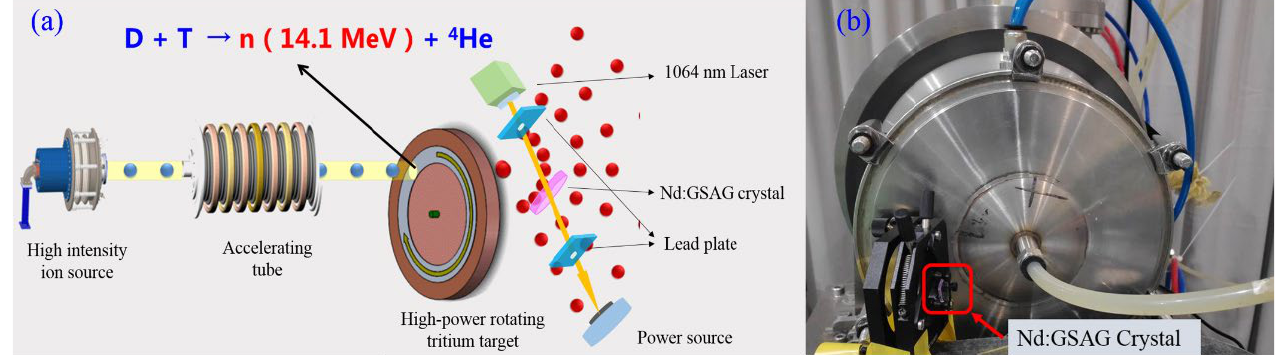
Figure 1. ( a ) The schematic diagram of the system for in-situ and real-time investigation of the neutron irradiation resistance ability of Nd:GSAG single crystal. ( b ) The physical map of the system for in-situ and real-time investigation of the neutron irradiation resistance ability of Nd:GSAG single crystal.